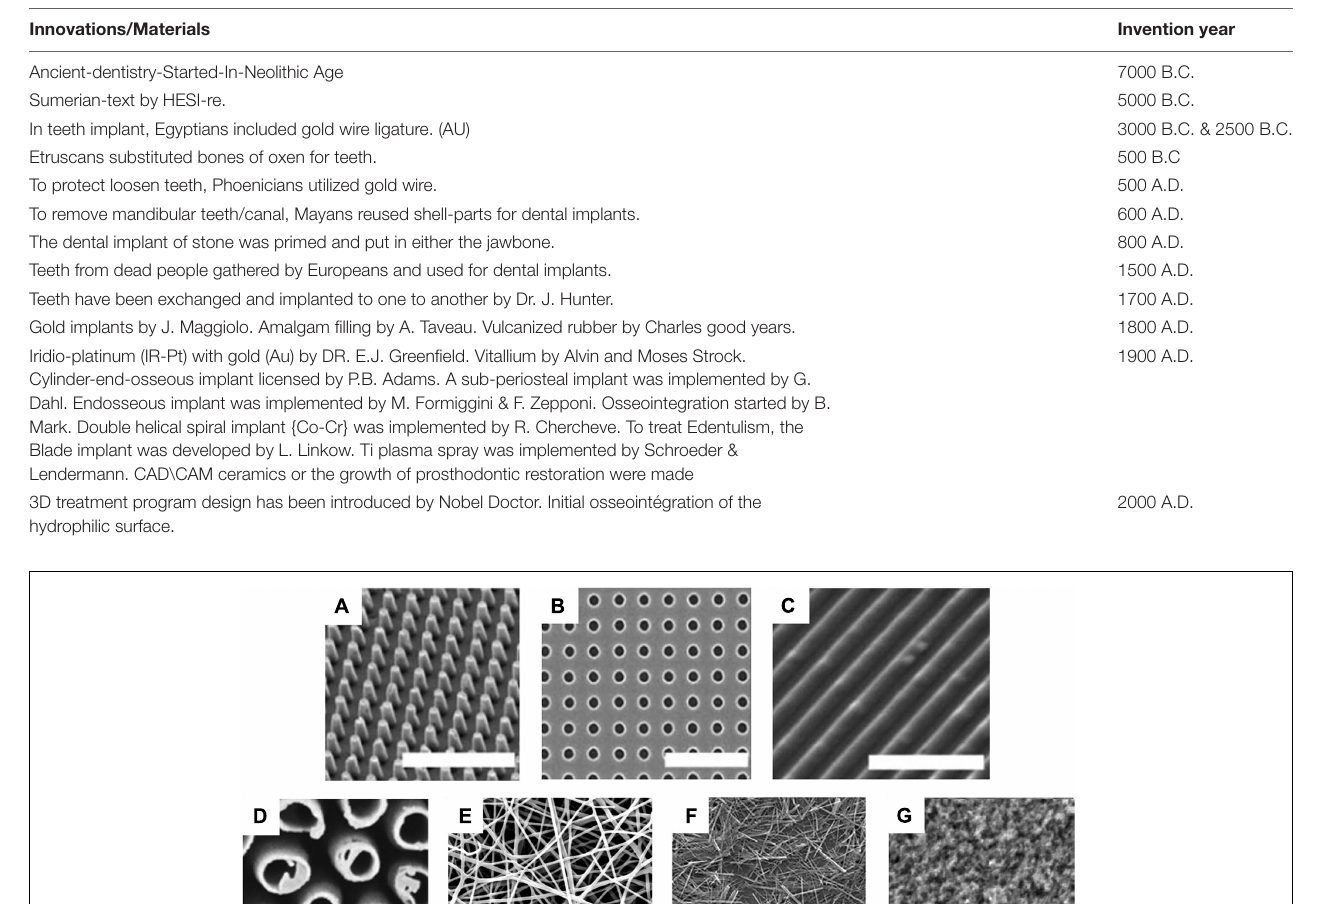
TABLE 2 | The evolution of dental implant materials and procedures.